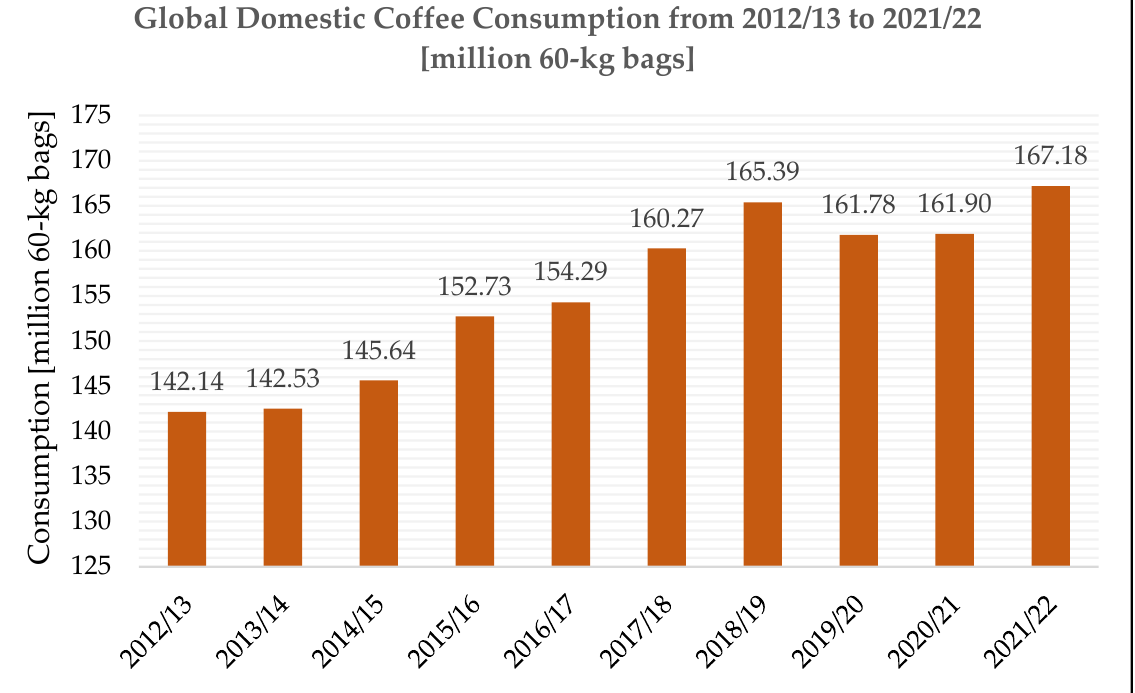
Figure 3. Global domestic coffee consumption from 2012/13 to 2021/22 in million 60 kg bags [56–58]. Of the approximately 100 species of the genus Coffea , C. arabica and C. canephora Pierre ex A. Froehner are mainly used for coffee production and are therefore the most economically valuable [15,59]. Together, these two species contribute to ca. 99% of global coffee production [59,60]. After cultivation, the cherry-like coffee fruits, hence alternatively named coffee cherries, are usually harvested by hand-picking [39,54,61]. Once harvested, the coffee fruits are processed via a dry or wet method [61,62] and converted to green